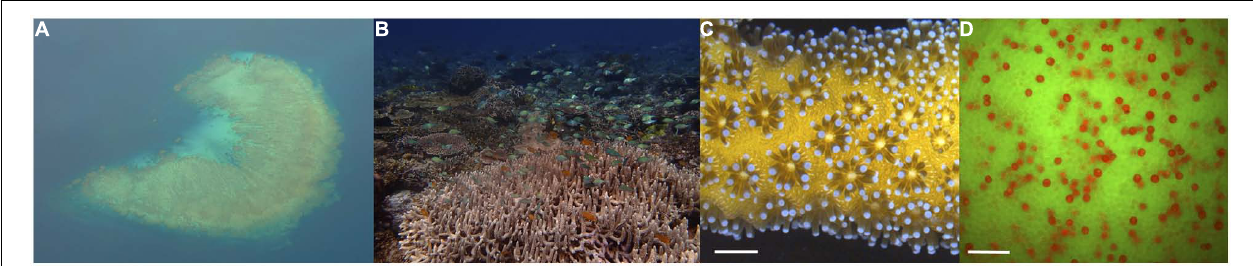
FIGURE 1 | “An oasis in a desert ocean”: coral reef seascapes powered by the coral–algal symbiosis. (A) Aerial view of coral reef architecture in shallow, oligotrophic tropical waters of Fiji. (B) Reef-building corals create habitats for vibrant communities boasting incredible biodiversity and productivity. This photograph was taken in the heart of the Coral Triangle in Raja Ampat, Indonesia. (C) Corals are colonial invertebrates, made up of genetically identical individual polyps connected by living tissue (coenosarc). The coral golden hue of